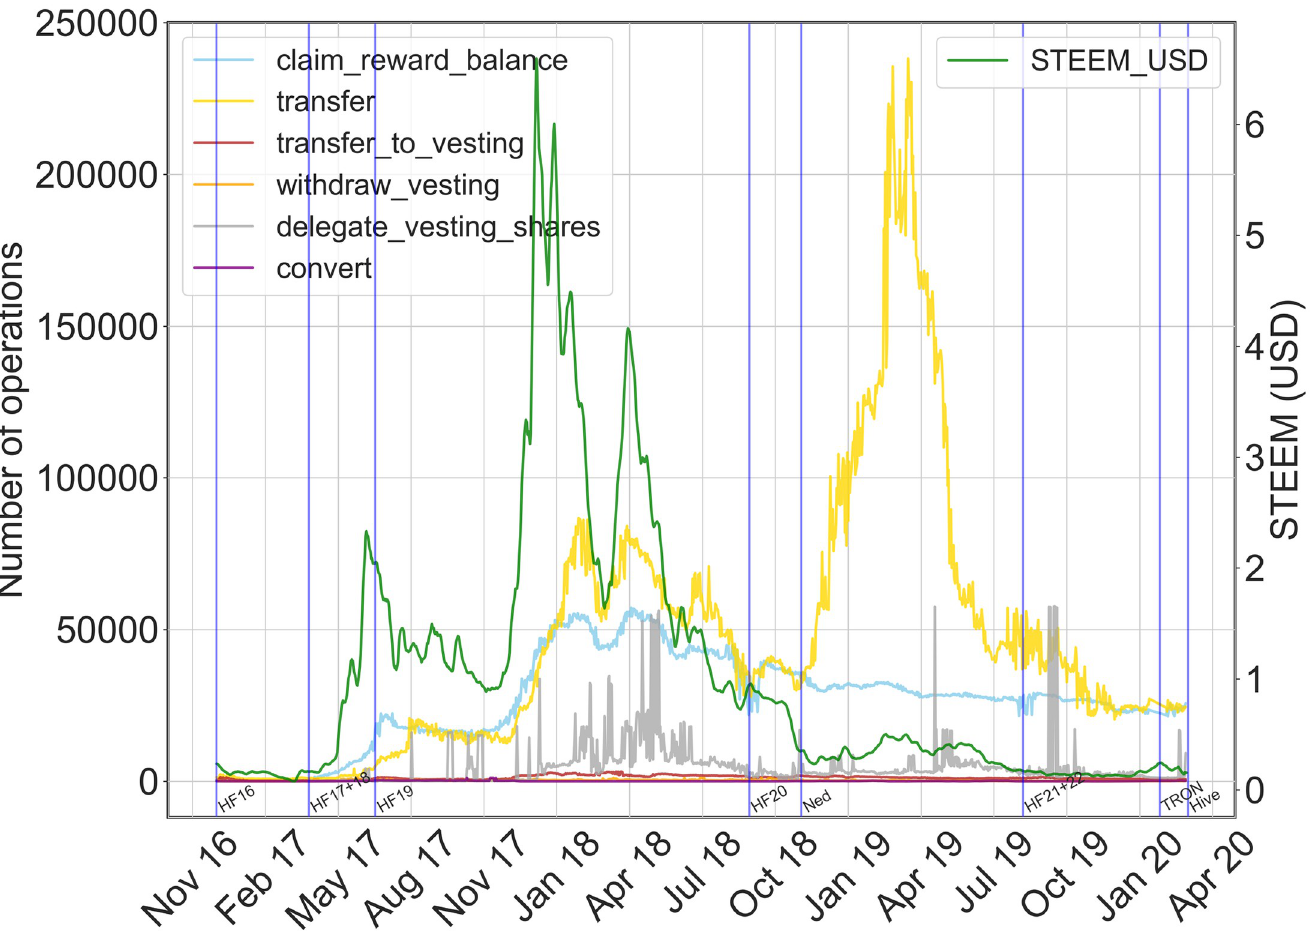
Fig 6. Daily volume of financial actions. Time plots for financial operations and STEEM price value in USD (green line). On the x-axis: time in days. On the left y- axis: daily volume of operations. On the right y-axis: STEEM price in USD. Blue vertical lines correspond to important events, like hard forks (HFXX), the crisis announcement by Scott (Ned), the selling of the company to TRON Foundation (TRON), and the Hive fork (Hive).